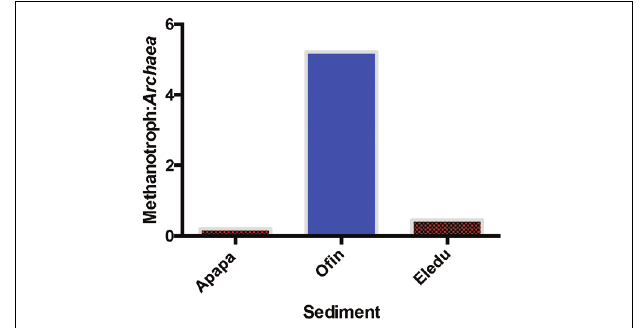
FIGURE 6 | Ratio of gammaproteobacterial methantroph quality-filtered amplicons to all archaeal quality-filtered amplicons in each